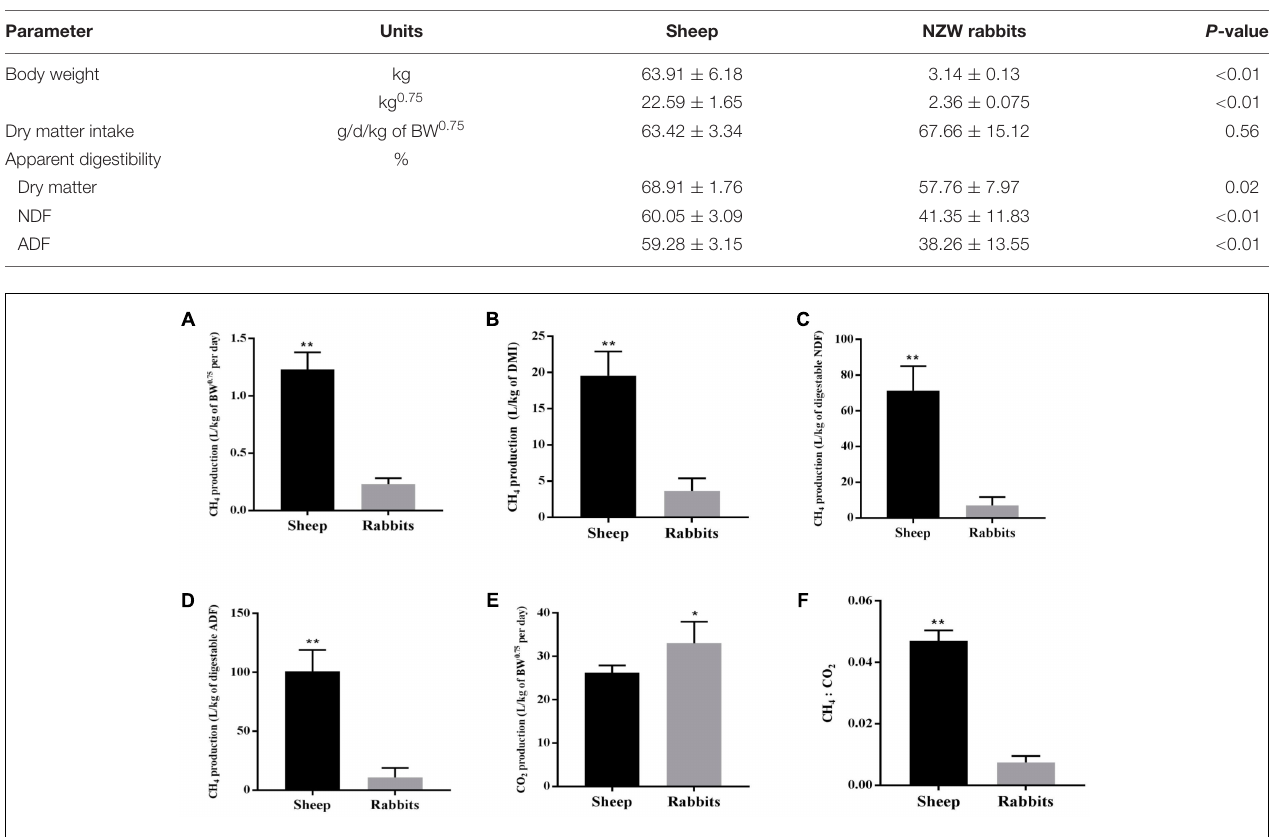
FIGURE 1 | Yields of CH 4 and CO 2 and their ratio of the sheep ( n = 5) and the rabbits ( n = 15). CH 4 yields per unit of metabolic body weight (A) , dry matter intake (B) , digestible NDF (C) , and digestible ADF (D) ; CO 2 yields per unit of metabolic body weight (E) and CH 4 : CO 2 ratio (F) of the sheep and the rabbits. ∗∗ P < 0.01; ∗ P < 0.05.